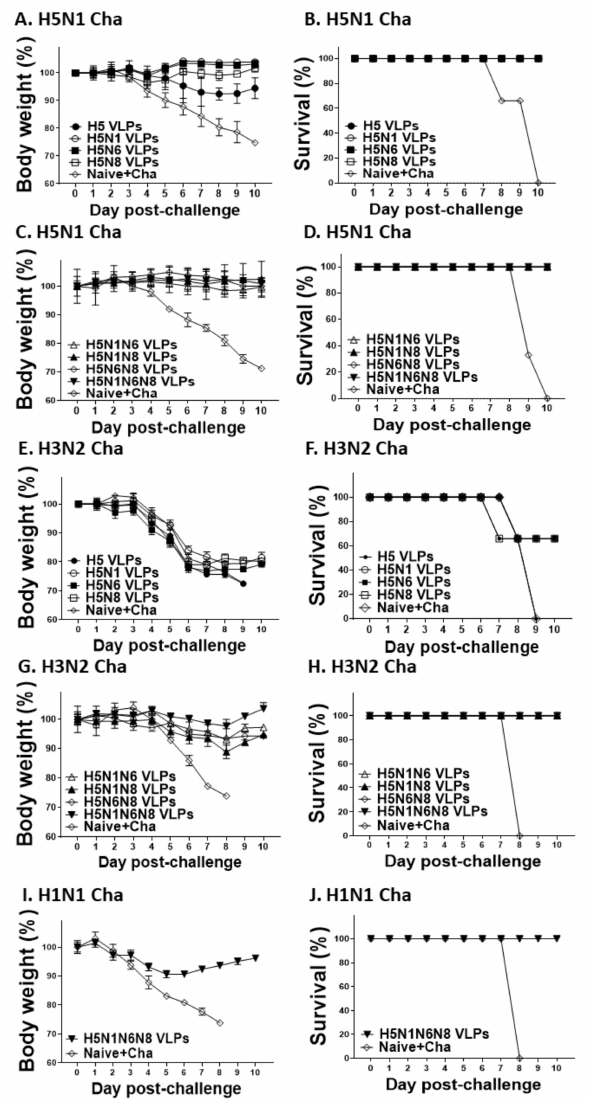
Figure 8. Protective efficacy upon influenza viruses challenges infection. VLP immunized mice were challenge infected with lethal doses of H5N1, H3N2, or H1N1 influenza viruses 4 weeks after boost immunization. Mice were monitored daily to record body weight changes after H5N1 ( A , C ), H3N2 ( E , G ), and H1N1 ( I ) infections, and their survival rates post-infection with H5N1 ( B , D ), H3N2 ( F , H ) and H1N1 influenza virus ( J